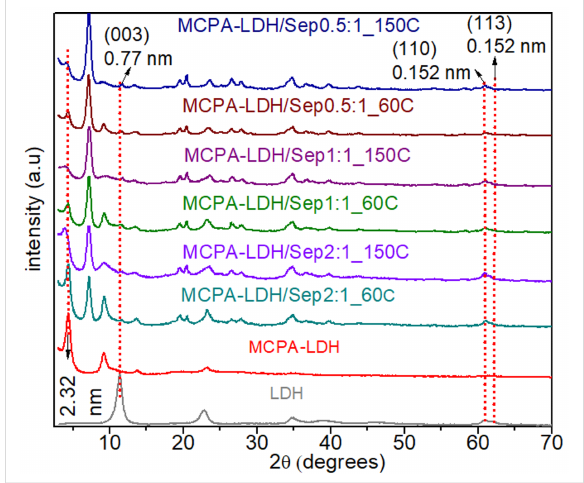
Figure 4: XRD patterns of hybrid nanoarchitectures prepared by coprecipitation of MgAl-LDH in the presence of sepiolite and MCPA at different theoretical LDH/sepiolite ratios ( x